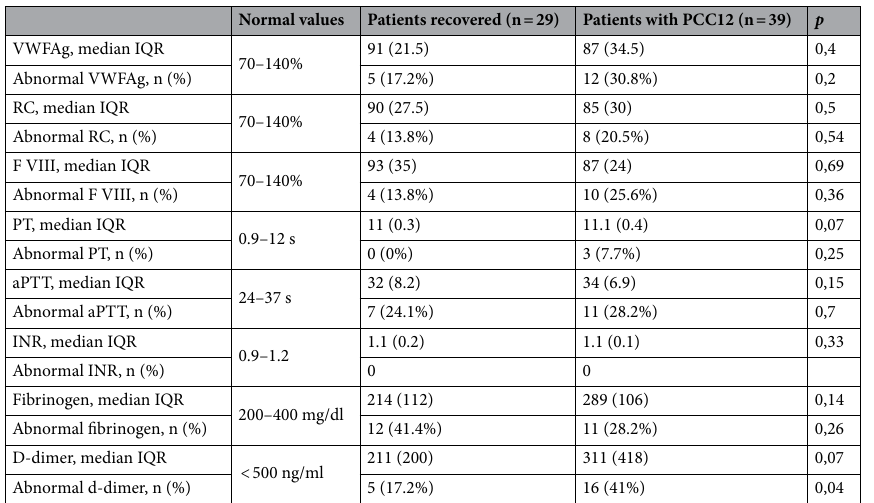
Table 3. Differences in the coagulation profile between patients with persisting symptoms at 12 weeks or more follow-up (PCC12) and patients recovered. Only patients assessed after 12 weeks were included in these comparisons. VWFAg von willebrand factor antigen, RC ristocetin cofactor, F VIII factor VIII, PT prothrombin time, aPTT activated partial thromboplastin time.